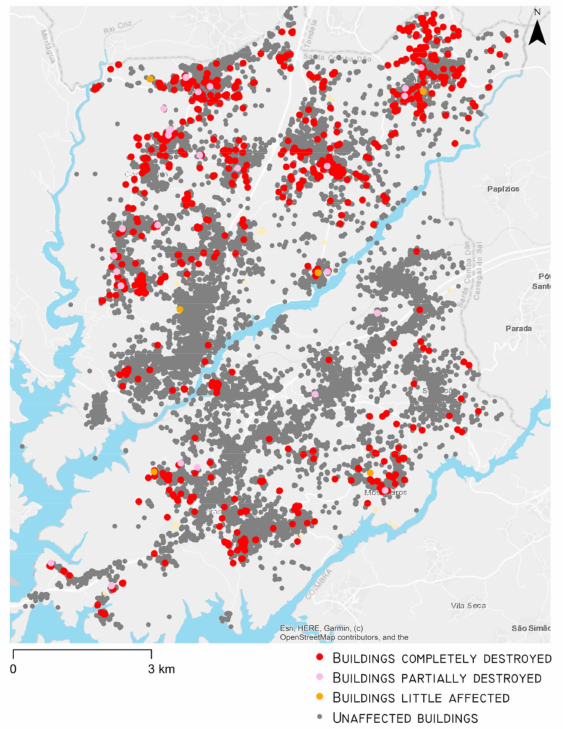
Figure 3. Degree of damage/destruction of buildings after the 2017 wildfire in Santa Comba D ã o